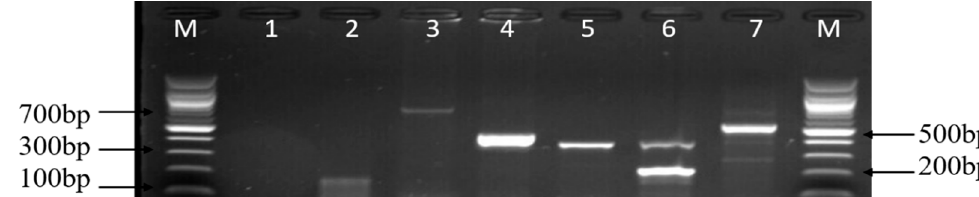
Figure 8. A representative gel image of various amplified antimicrobial resistance genes of Campylobacter isolates. Lanes M: DNA ladder (100 bp); lane 1: negative control; lane 2: tetM gene (158 bp); lane 3: aac(3)-IIa (aacC2) a gene (740 bp); lane 4: gyrA gene (441 bp); lane 5: ermB gene (320 bp); lane 6: